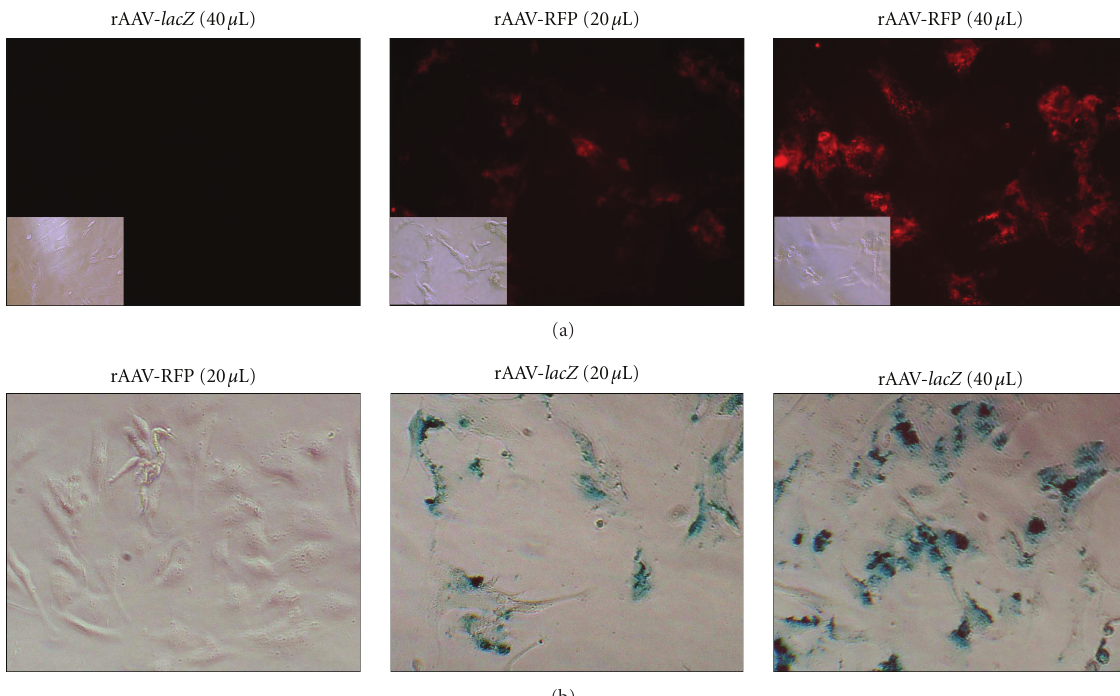
Figure 1: rAAV-mediated gene transfer in primary human chondrosarcoma cells in vitro . Cells in monolayer culture were transduced with rAAV-RFP or rAAV- lacZ (20 or 40 μ L) and processed to monitor transgene expression 20 days after vector application by analyzing live fluorescence ((a) magnification × 40; insets: same fields under transmitted light) and by X-gal staining ((b) magnification × 20).